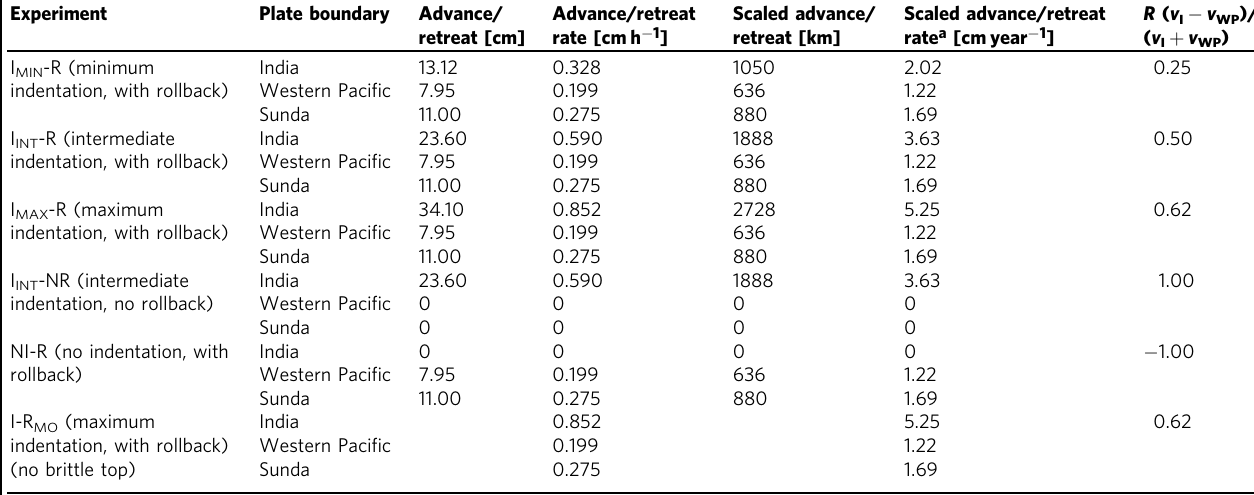
Table 1 Experimental and scaled displacements and displacement rates of the three plate boundaries Experiment